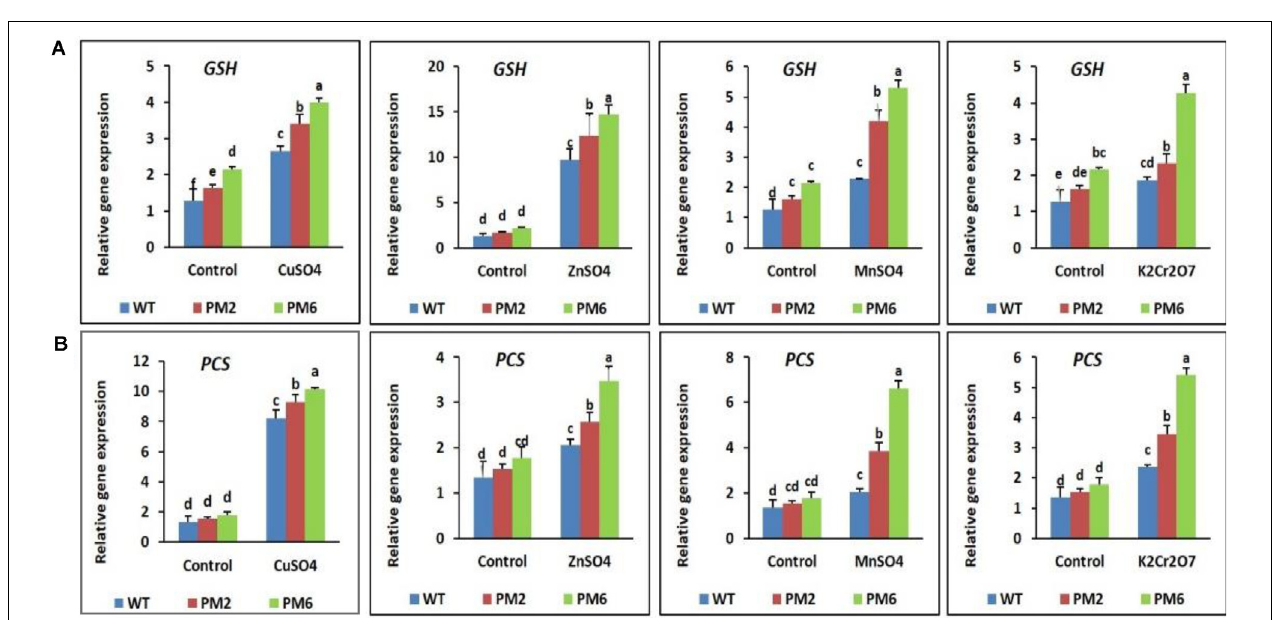
FIGURE 8 | Expression analysis of the antioxidant-related genes superoxide dismutase [ SOD, (A) ], catalase [ CAT, (B) ], and peroxidase [ POX, (C) ] in the T 2 -PM6, T 2 -PM2, and WT plants after exposure to the indicated heavy metals. Data were taken on the thirtieth day after starting the experiments. Error bars show the SEM.